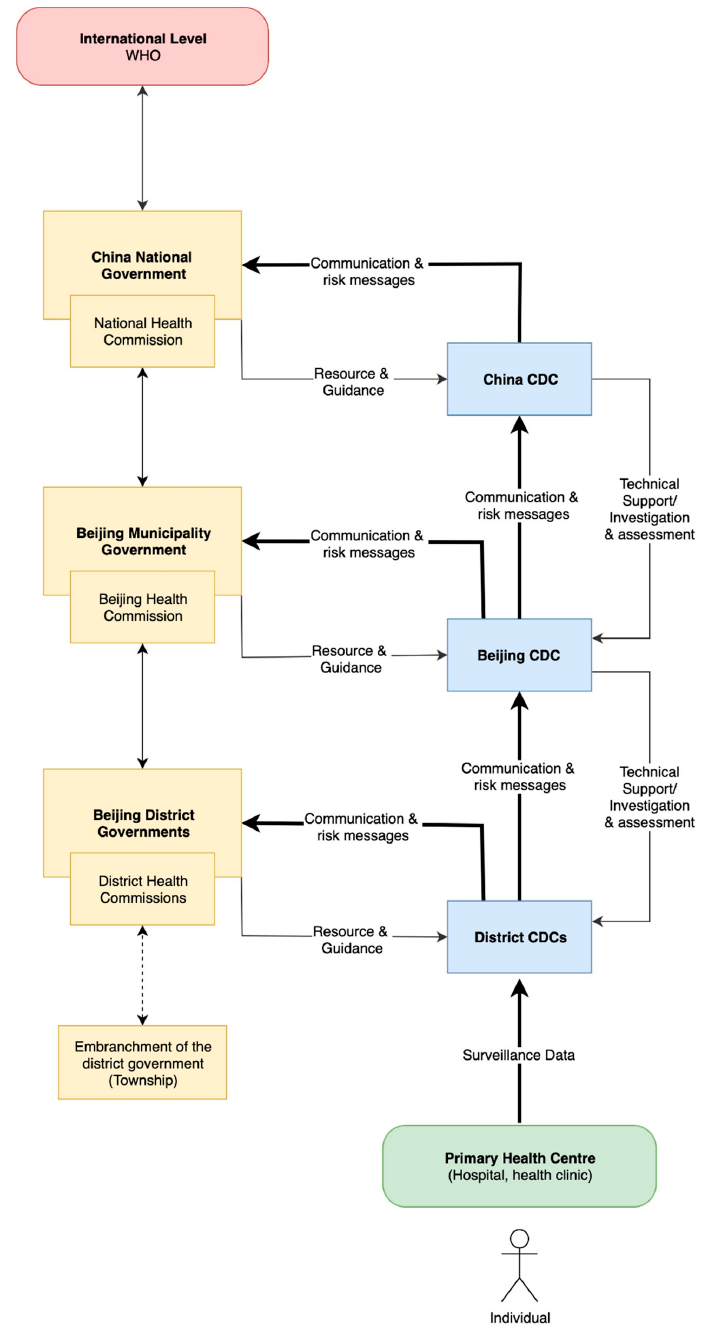
Figure 2. Simplified system map of authorities involved in vector-borne disease surveillance and response in Beijing Municipality. Green box represents the primary care centre and the entry point of the individual into the healthcare system. Yellow boxes represent administrative health authorities. Blue boxes represent technical health authorities. Interactions between authorities are indicated using black arrows. This system map was developed based on qualitative data from experts from Beijing. Human case reporting and vector surveillance operate within separate reporting networks developed at the national level by China CDC, respectively the National Infectious Disease Reporting Information System in China (NIDRIS) and the National Vector Surveillance Networks (NVSN)